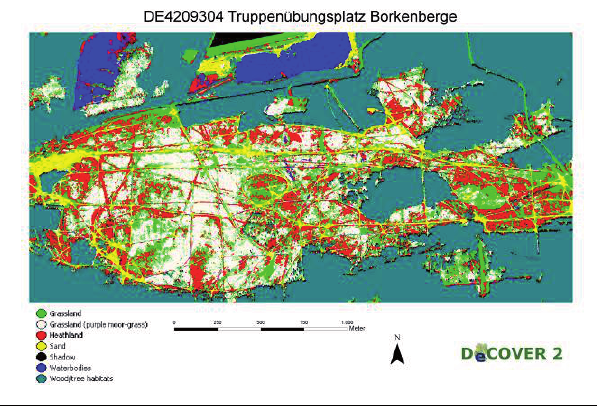
Table 4. Summary results of field transect validation